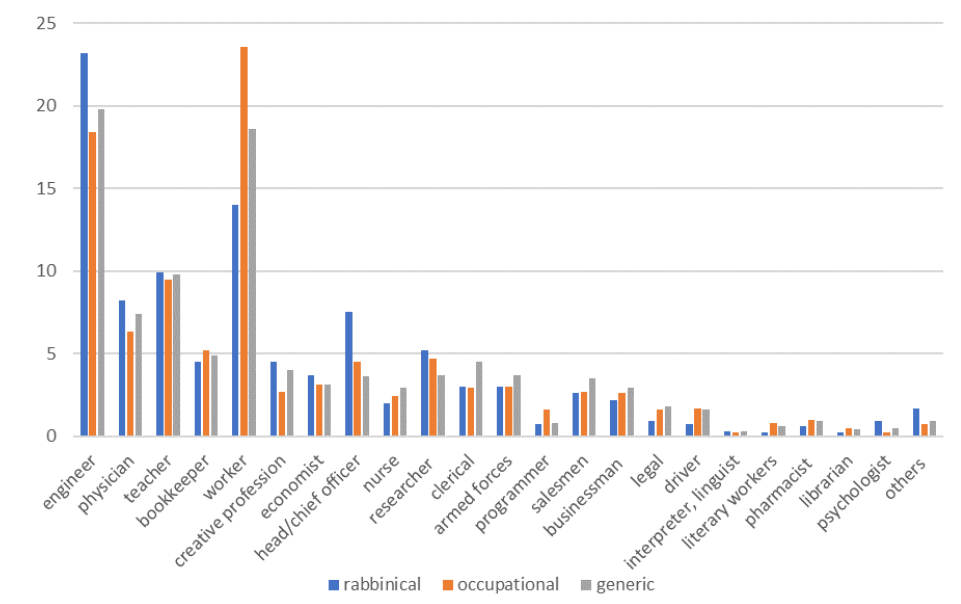
Figure 1. Occupational distributions of the three groups of surnames according to the 23 professional activities